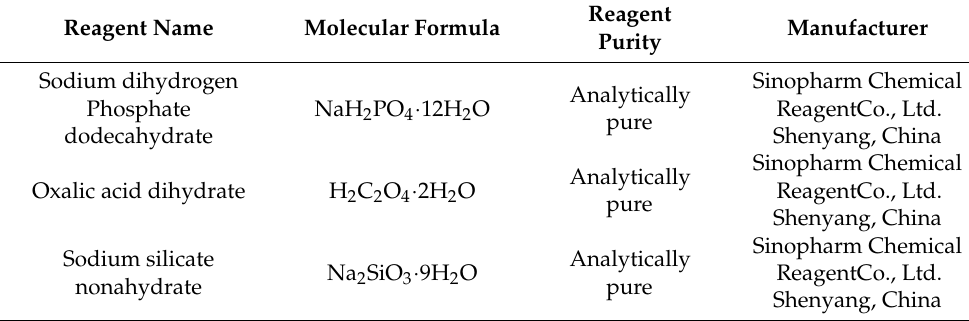
Table 2. Experimental